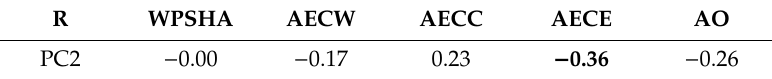
Table 12. Correlation coe ffi cients (R) between PC2 and the Atmospheric circulation-indices based predictors (bold font indicates statistically significant values at the 5% level, and − 0.00 means the value is less than − 0.005).